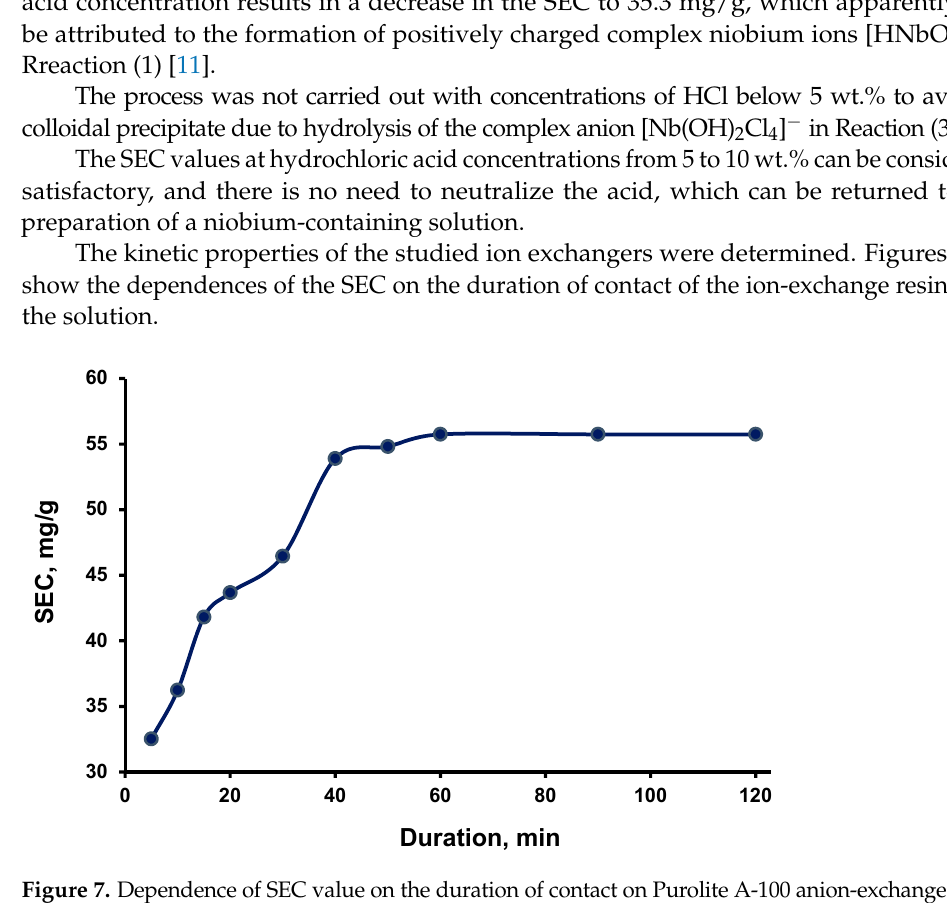
Figure 7. Dependence of SEC value on the duration of contact on Purolite A-100 anion-exchange resin.